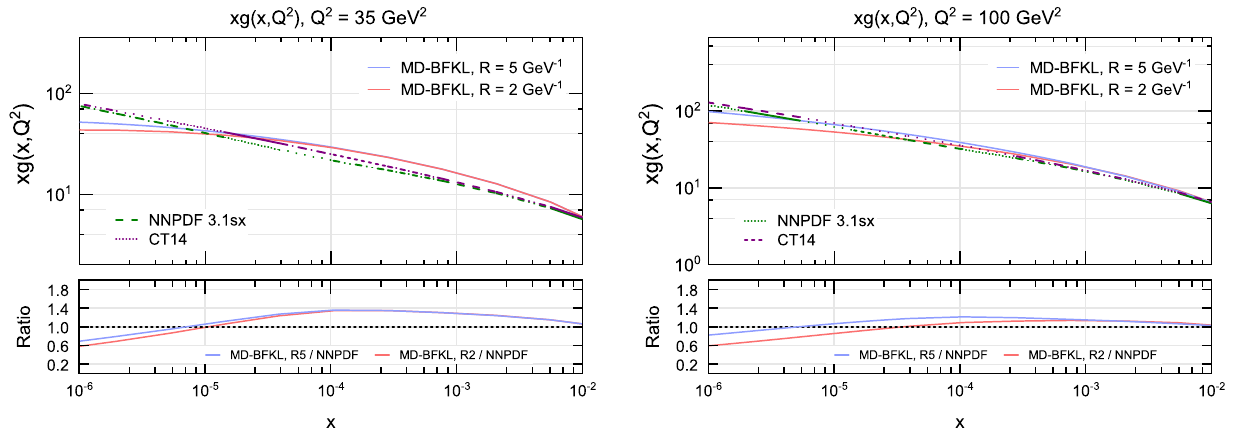
evolution at x = 10 − 4 and 10 − 6 . b T = 5 GeV 2 and 50 GeV 2 . Results are T